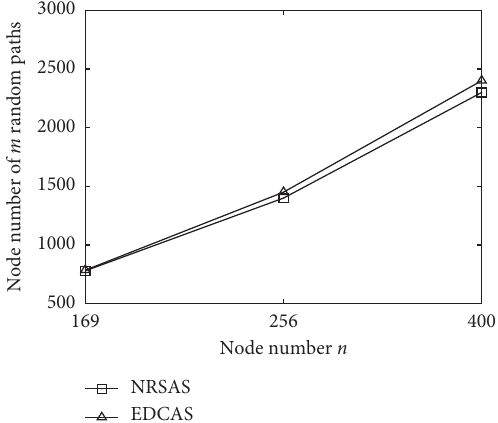
Figure 14: The effect of the node number on the random path.